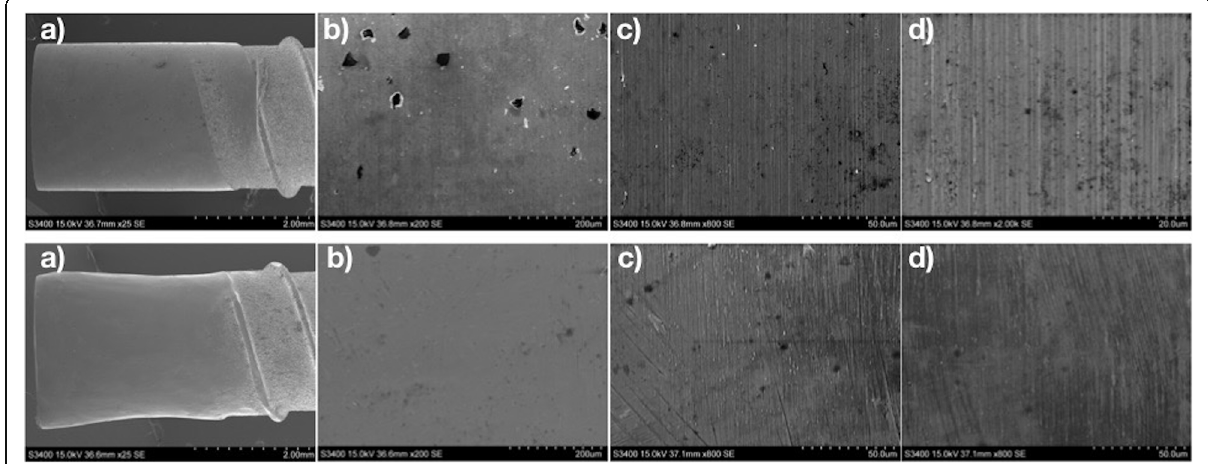
Fig. 6 Scanning electron micrographs of a bone-level implant with industrially machined implantoplasty (IMP1) (upper images) and with manual implantoplasty (IMP2) (lower images) at ( a ) 25×, ( b ) 200×, ( c ) 800×, and ( d ) 2000× magnification. Titanium particles can be observed in the IMP1 group images at magnifications of 200× and